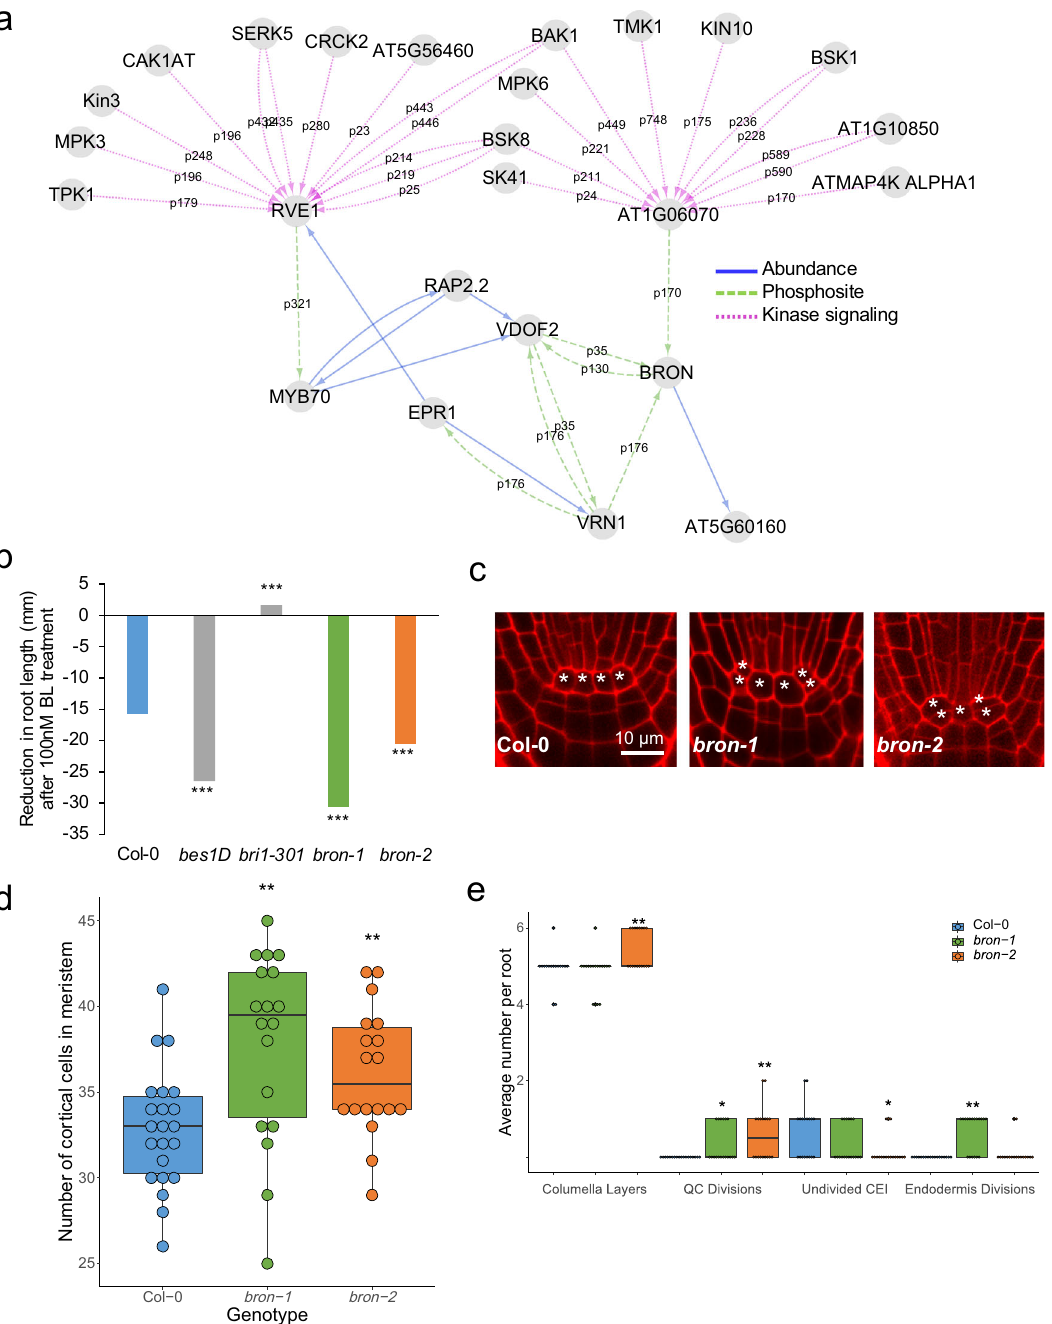
Fig. 4 bron mutant roots are hypersensitive to BL treatment and display excessive cell divisions. a BRON subnetwork. Edge labels represent the phosphosite used to predict that regulation. b bron mutants are hypersensitive to 100 nM BL treatment ( n >27). c Representative images of Col-0 wild type, bron-1 , and bron-2 root stem cell niches. * denote Quiescent Center (QC) cells. d The number of meristematic cells in 5-day-old roots ( n = 18). e Average number of columella cell layers, QC divisions, undivided Cortex Endodermis Initials (CEI), and endodermis division in 5-day old roots ( n = 18). d , e the centerline represents median; box bounds represent 25th and 75th percentiles; whiskers represent minimum and maximum. Colored dots represent individual data points. b , d , e * denotes p < 0.05, ** p < 0.01, *** p < 0.001 using a generalized linear model ( b ) or two-tailed Wilcoxon test ( d , e ). For all statistical tests, no multiple testing correction was mutant. We found that four cyclins are DE in the bron-2 mutant: three are repressed by BRON ( CYCD3;1, CYCP4;1, CYCP4;2) , whereas one is induced by BRON ( CYCP3;2 ). Further, two of these cyclins, CYCD3;1 , and CYCP4;1 , are signi fi cantly induced by BL at 4 and 8 h after treatment Supplementary Figure 6).